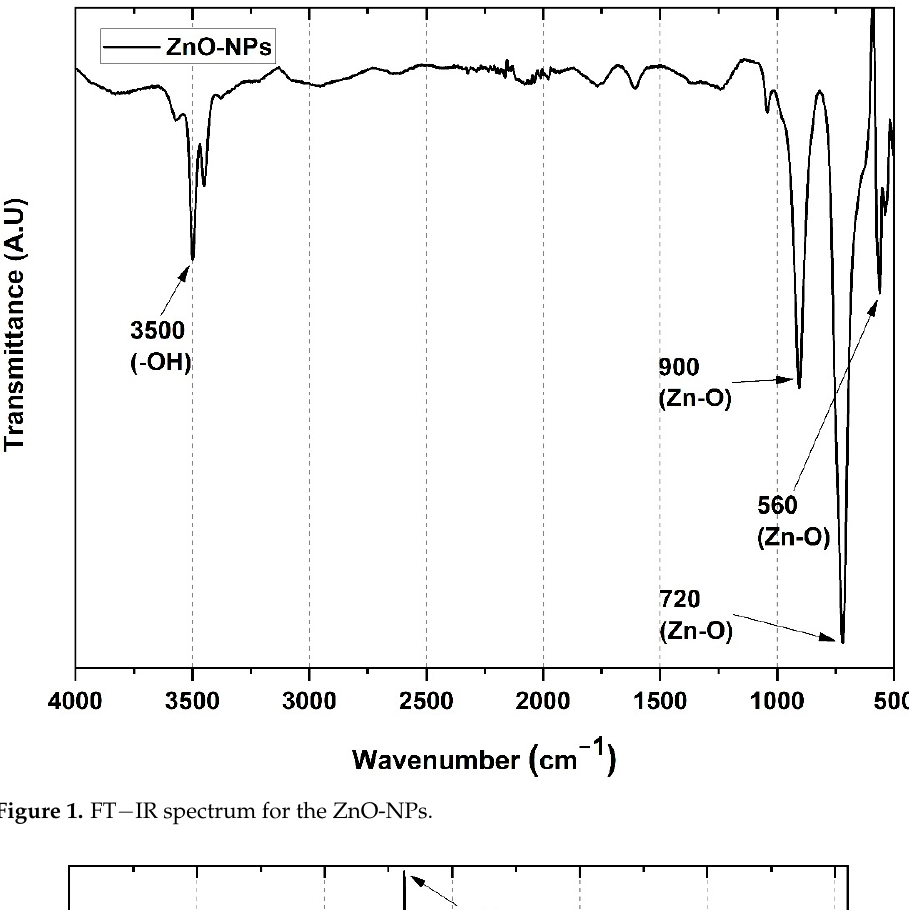
where K is Scherrer constant, and the crystalline shape factor is 0.89, λ represents the wavelength of X-ray source 1.5405 Å used in XRD, β is full width at half maximum of diffraction peak, and θ is the Bragg angle of the intense peak. In this regard, from the diffractogram data of the ZnO-NPs, the average crystallite size calculated is 30.13 nm. 3.2.3. Thermal Analysis for the ZnO-NPs The thermal properties of the ZnO-NPs were determined by thermogravimetric anal- ysis (TGA). TGA exhibits the mass loss (in percentage) with the degradation temperature of the nanocomposites. Figure 3 shows the thermogram with two stages of degradation and two clear degradation stages. The first degradation stage, with its maximum peak at 165 °C (1.8%), is attributed to water absorption and the presence of the hydroxyl groups from ZnO nanoparticles. The second degradation stage at 408 °C (1.4%) probably corre- sponds to the complete decomposition of ZnO after calcination, indicating that the zinc oxide is thermally stable [32].